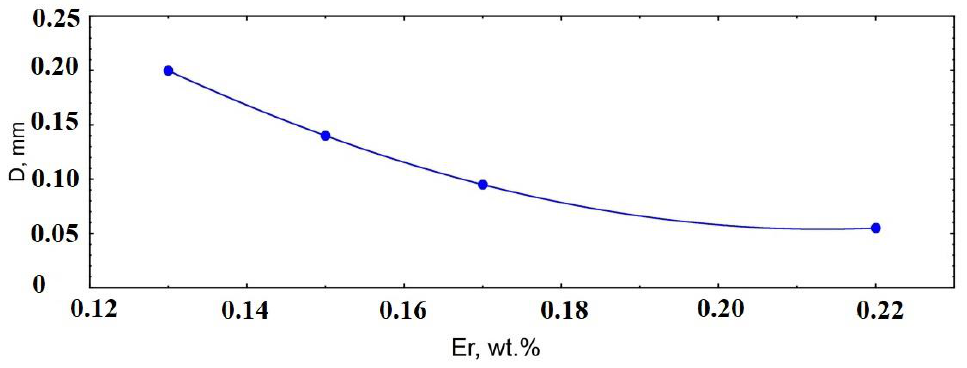
Figure 8. The dependence of the cast grain size on the content of erbium in the alloy.